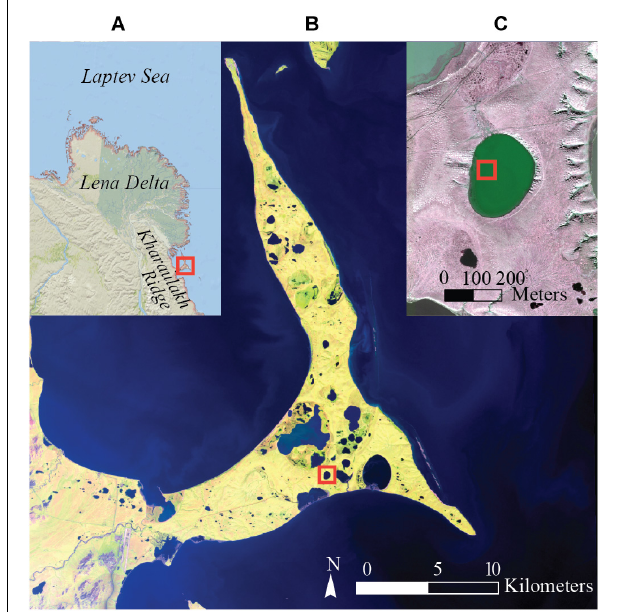
FIGURE 1 | Bykovsky Peninsula in northeastern Siberia. (A) Bykovsky Peninsula (red square) at the Laptev Sea coast, southeast of the Lena Delta and east of the Kharaulahk Ridge, (B) Goltsovoye Lake (red square) close to southern coast of Bykovsky Peninsula, (C) coring location PG2412 and PG2420 (red square; ∼ 20 m apart) in Goltsovoye Lake. Source imagery: (a) ESRI Basemap: National Geographic World Map, (b) ESA Sentinel-2 False Color Composite (11-8-2) acquired 2019-08-03, (c) World View 3 Image acquired 2019-09-02